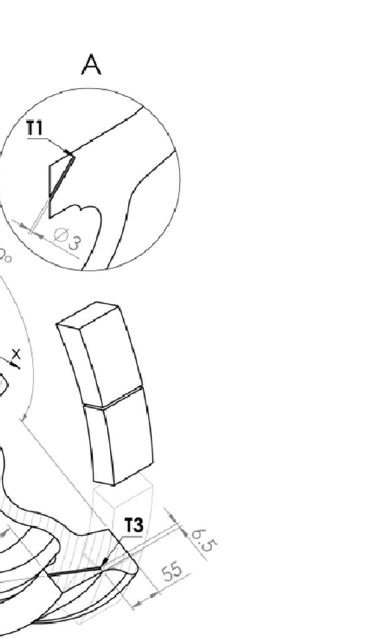
Figure 3. A full-scale inertia dynamometer for testing friction pairs of railway brakes at the Railway Research Institute in Warsaw: ( a ) flywheels, ( b ) test object (tread brake in 2xBgu configuration). Photographs by courtesy of the Railway Research Institute in Warsaw, Poland.